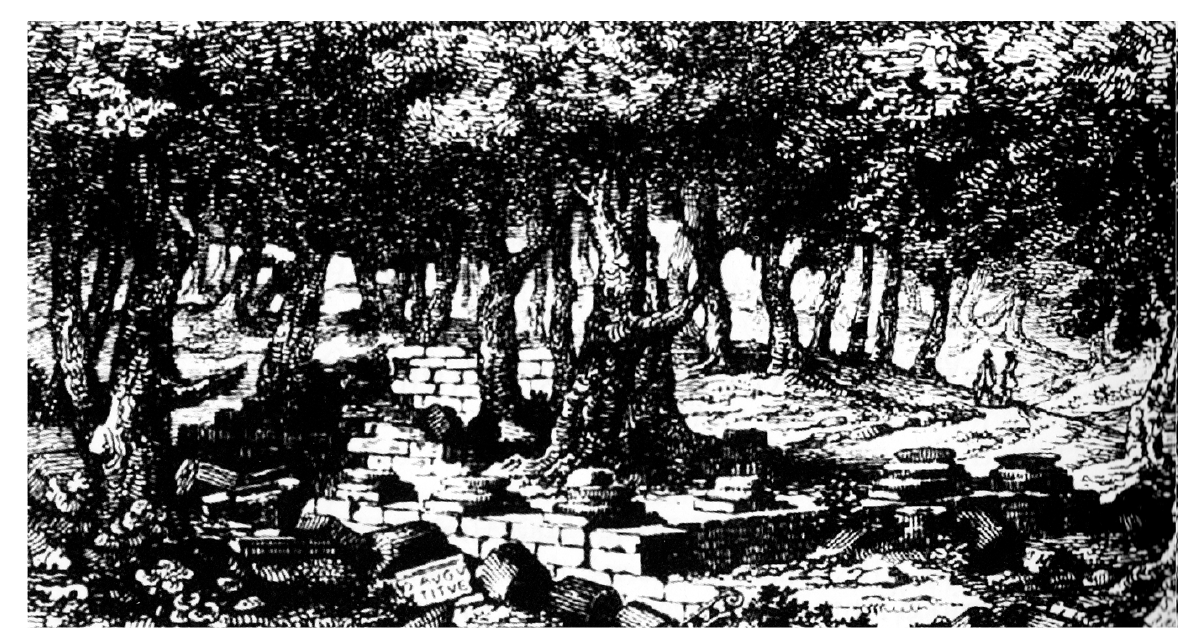
Figure 2. Representation of the ruins of the temple of Antas (from Lamarmora [40]).